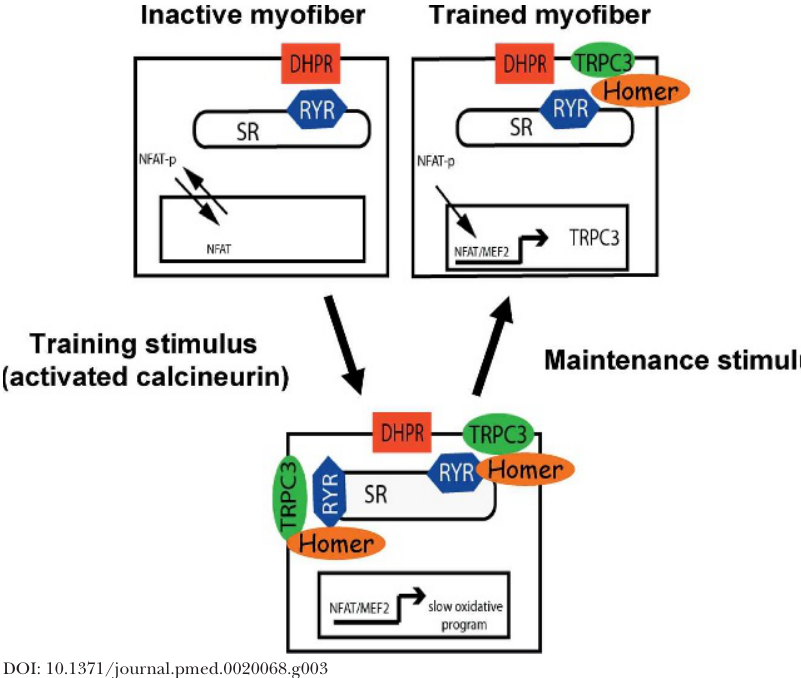
Figure 3. Proposed Model for Cellular Memory, Based on Activity-Induced Changes in TRPC3—A Putative Store-Operated Calcium Channel Neural activation triggers muscle contraction by releasing calcium stored within the sarcoplasmic reticulum (SR) through mechanisms that involve channel proteins called dihydropyridine receptors (DHPR) and ryanodine receptors (RYR). Inactive myofi bers have a low abundance of TRPC3 channels, and calcium released from SR is not suffi cient to maintain the calcium-regulated transcription factor NFAT in the nucleus. Under conditions of tonic activity (training stimulus), TRPC3 channels become more abundant, and are regulated by the scaffold protein Homer, which binds RYR. Under these conditions, the combined effect of calcium entering the cell via TRPC3 channels and exiting the SR via RYR channels maintains NFAT in the nucleus, where it promotes transcription of genes that establish the slow oxidative phenotype in myofi bers. Once the slow oxidative phenotype is established (trained myofi ber), the continued expression of TRPC3 allows this state to be maintained even with a less intensive tonic activity pattern of neural stimulation. (Figure adapted from